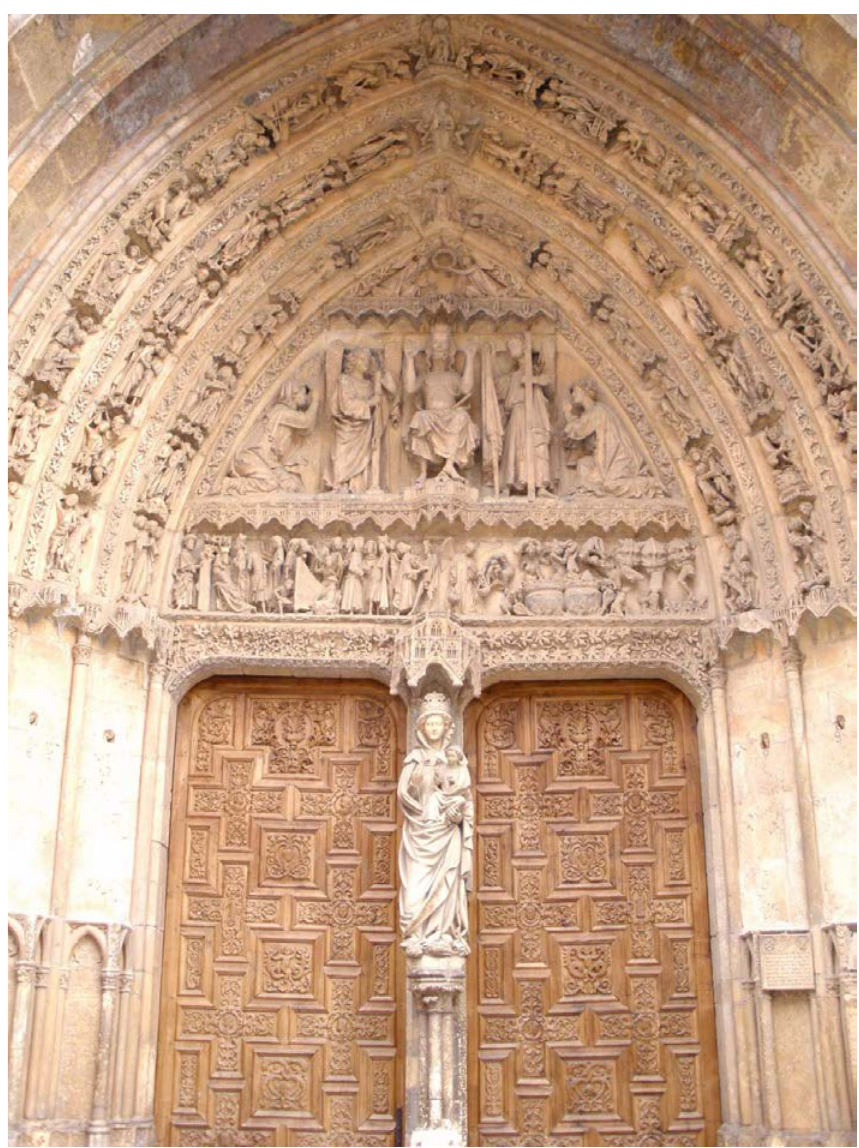
Figure 4. León Cathedral, mullion with the Virgen Blanca at the Portal of the Last Judgment . Central portal of the West Facade, mid. 13th century.